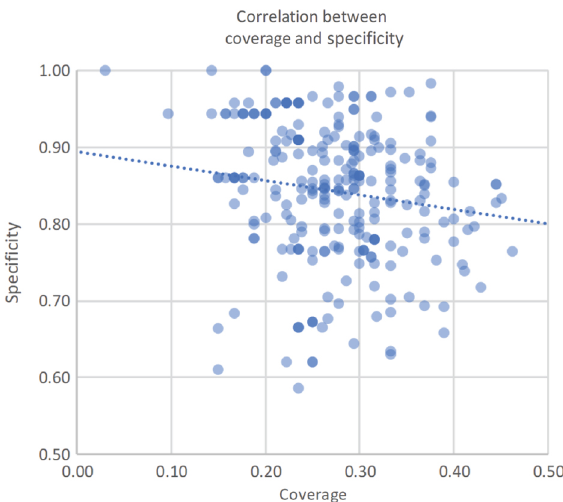
Figure 2: The correlation between the coverage and specificity measures in all the MetaboLights resources. The dotted line shows the slight negative trend between the two measures.